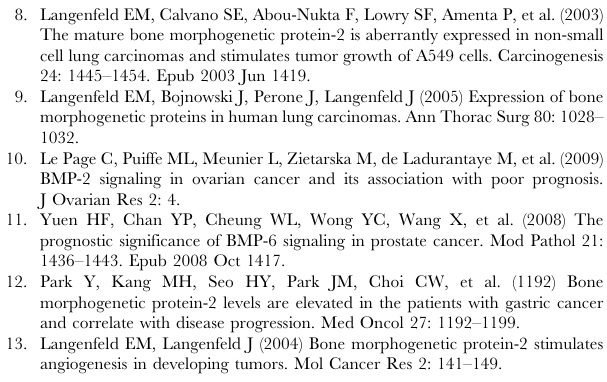
Figure S1 DMH2 decreases phosphorylated Smad 1/5/ 8 expression in A549 cells. Western blot analysis for pSmad 1/ 5/8 on A549 cells treated with 1 m M DMSO, DMH1 or DMH2 for 12, 24, and 24 hours.